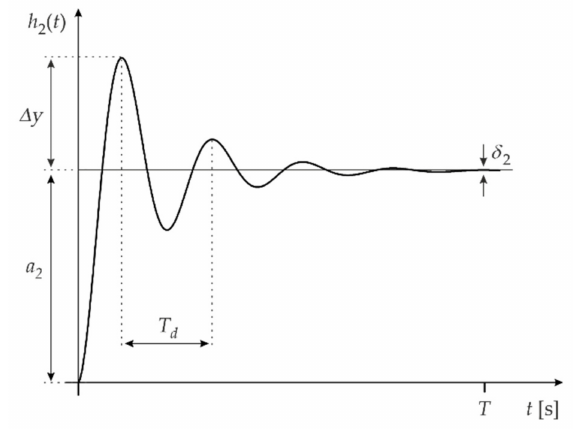
Figure 2. Step response of a second-order component.